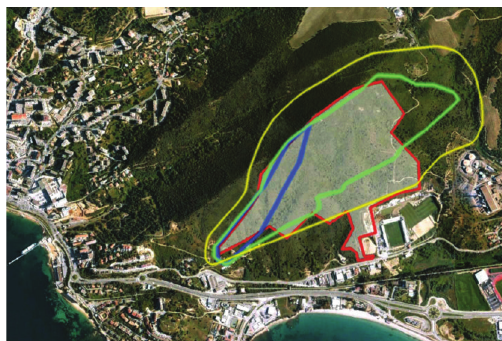
Figure 13: Case 1: Simulations results and observations for the Vazzio fire. Blue: simulated fire contour at 15:30 (after 1 h), Green: simulated contour at 18:30, Yellow: Simulated contour at 18:30 (non coupled); Red: final observed contour of the fire.